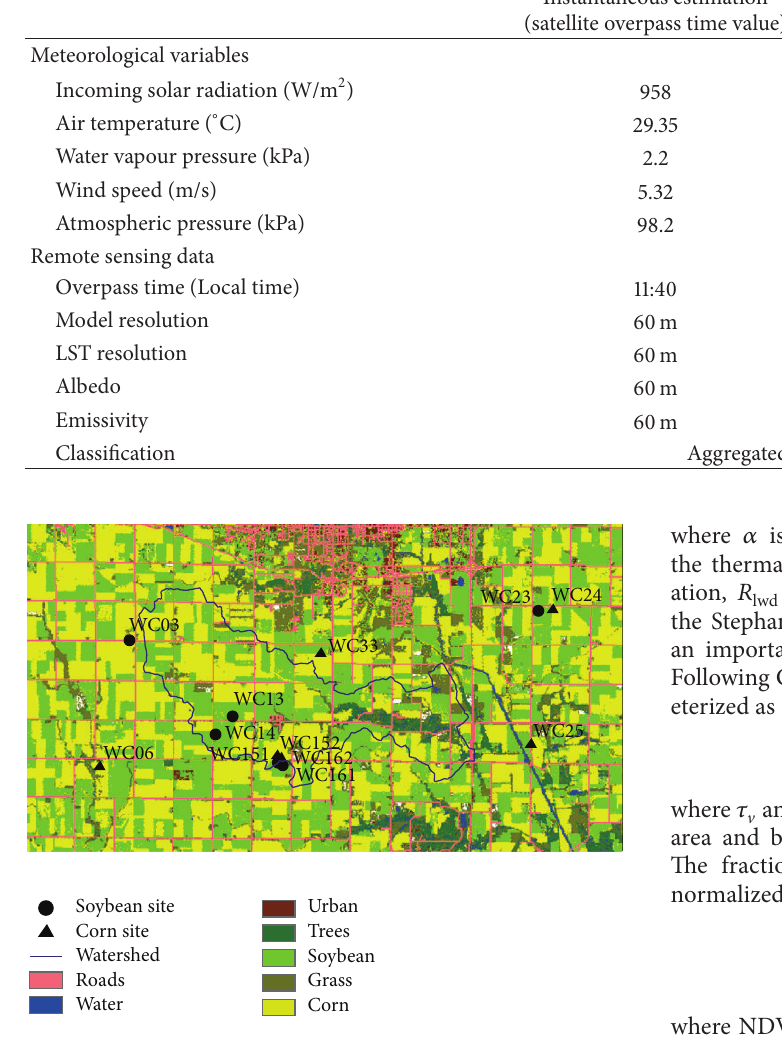
Figure 1: The distribution of flux towers in the Walnut Creek catchment and the land use